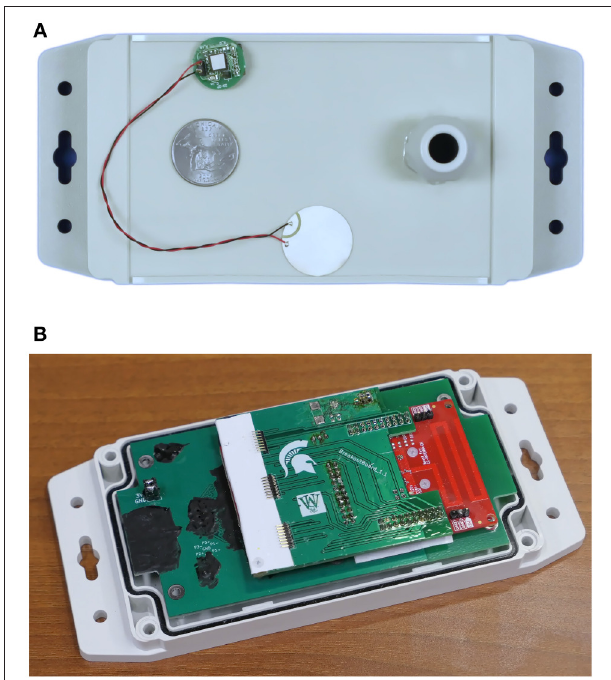
FIGURE 7 | Initial wireless sensor box that was installed in autumn of 2017 and failed during the 2017–2018 winter due to water ingress. This box was deployed as a means to provide rapid-verification of the PZT selection and PFG data-logging capability. (A) Initial prototype’s weather proofing enclosure, a sample PFG sensor and PZT are shown next to a U.S. quarter for scale. (B) Launchpad with adapter PCB to interface with three PFG sensors, black sections are weatherproofed debugging pads, and the batteries are mounted on the underside of the PCB.